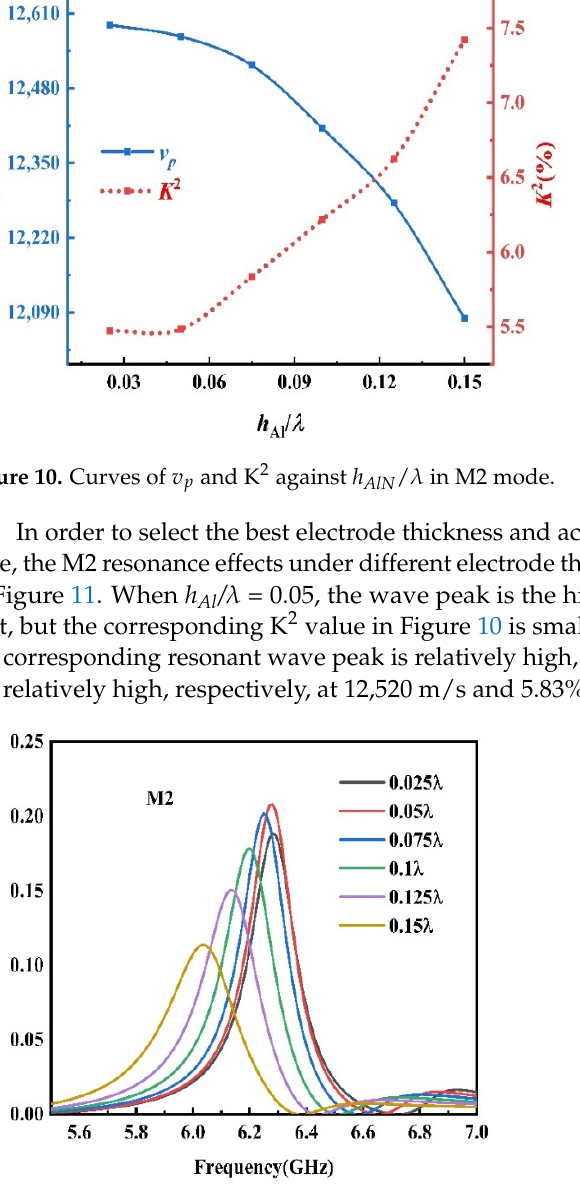
Figure 11. The influence of electrode thickness on resonance displacemen.